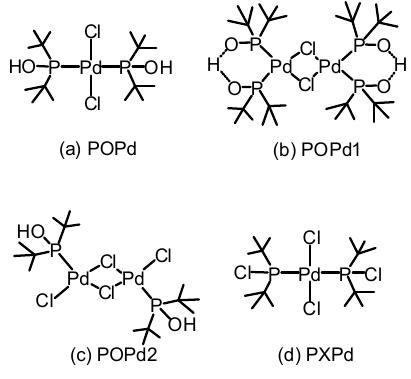
Figure 1. Structures of several palladium(II) complexes employed in this